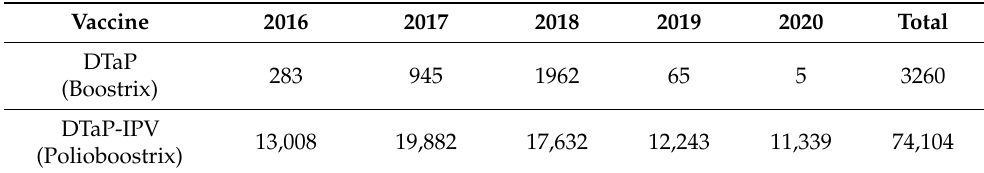
Table 1. Doses of vaccine administered in subjects aged 12–18 years from 2013 to 2020, per type of vaccine and year of